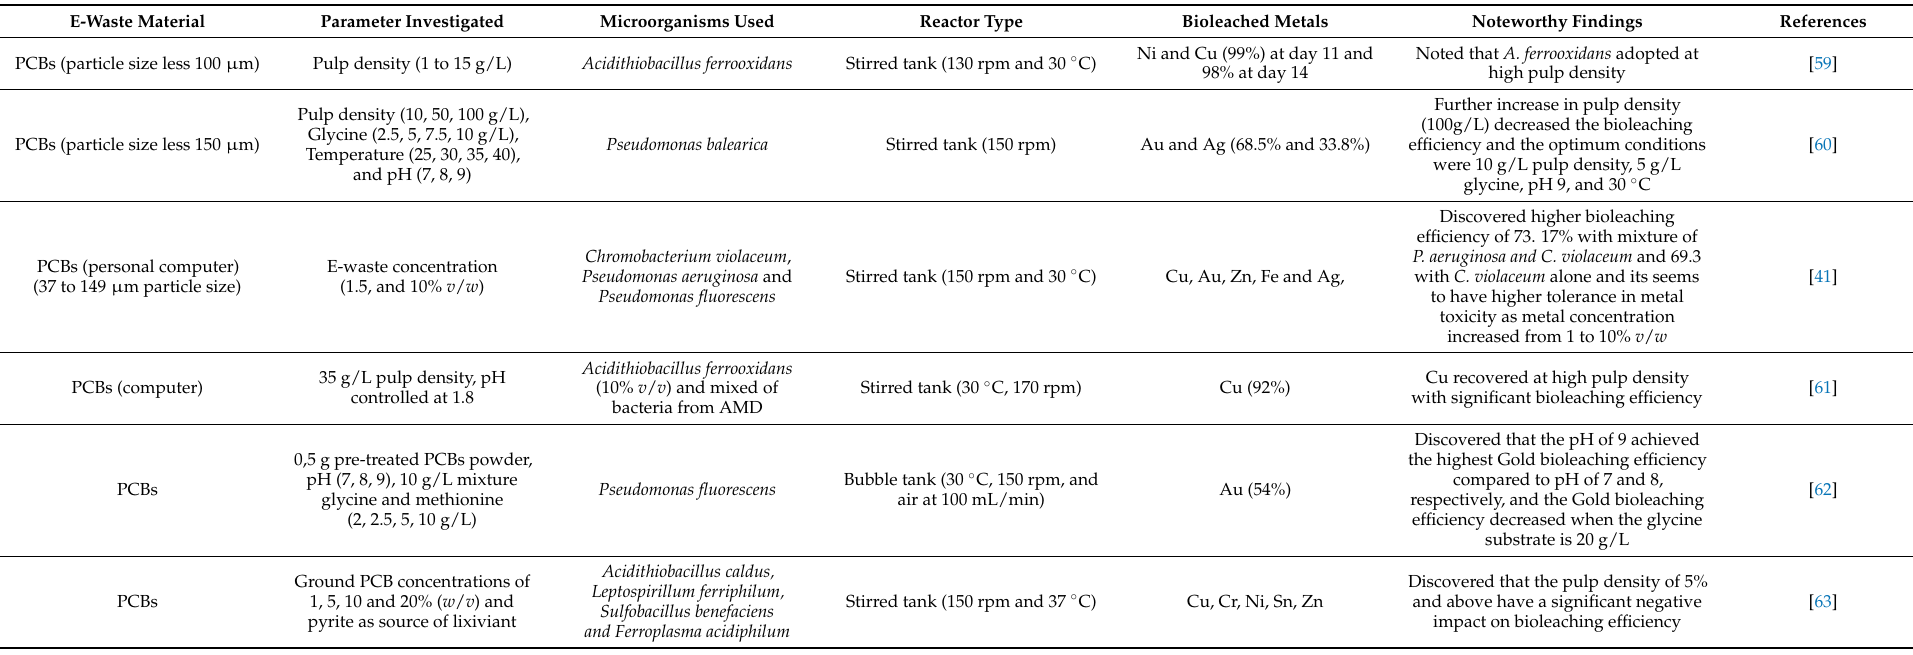
Table 3. The bioleaching of metals from e-waste by different biological